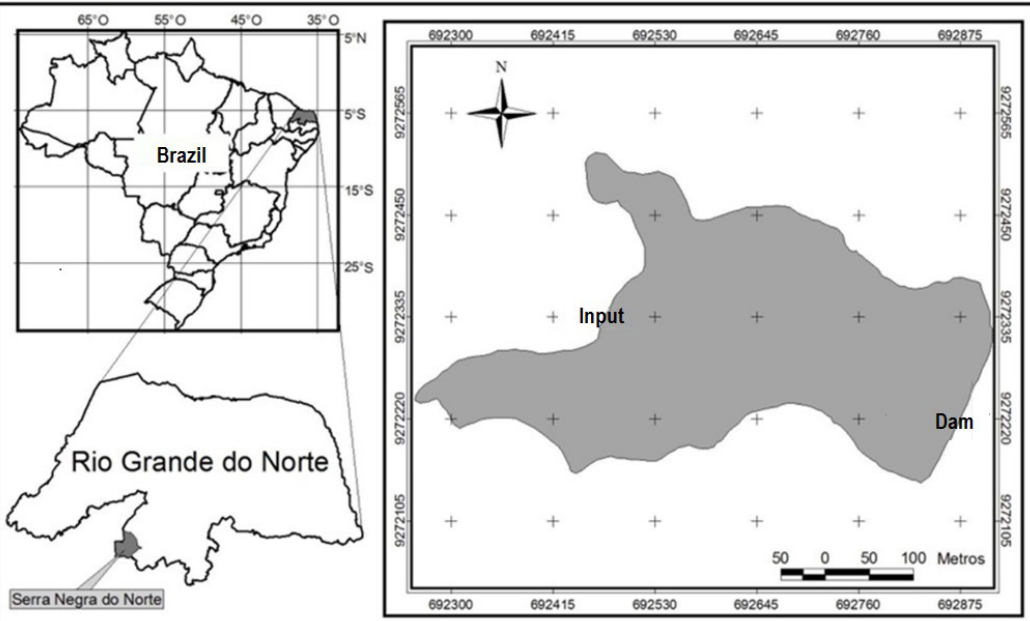
Figure 1. Location of the Estação Ecológica do Seridó (ESEC-Seridó), Serra Negra, Rio Grande do Norte, Brazil and sampling points (entrance and